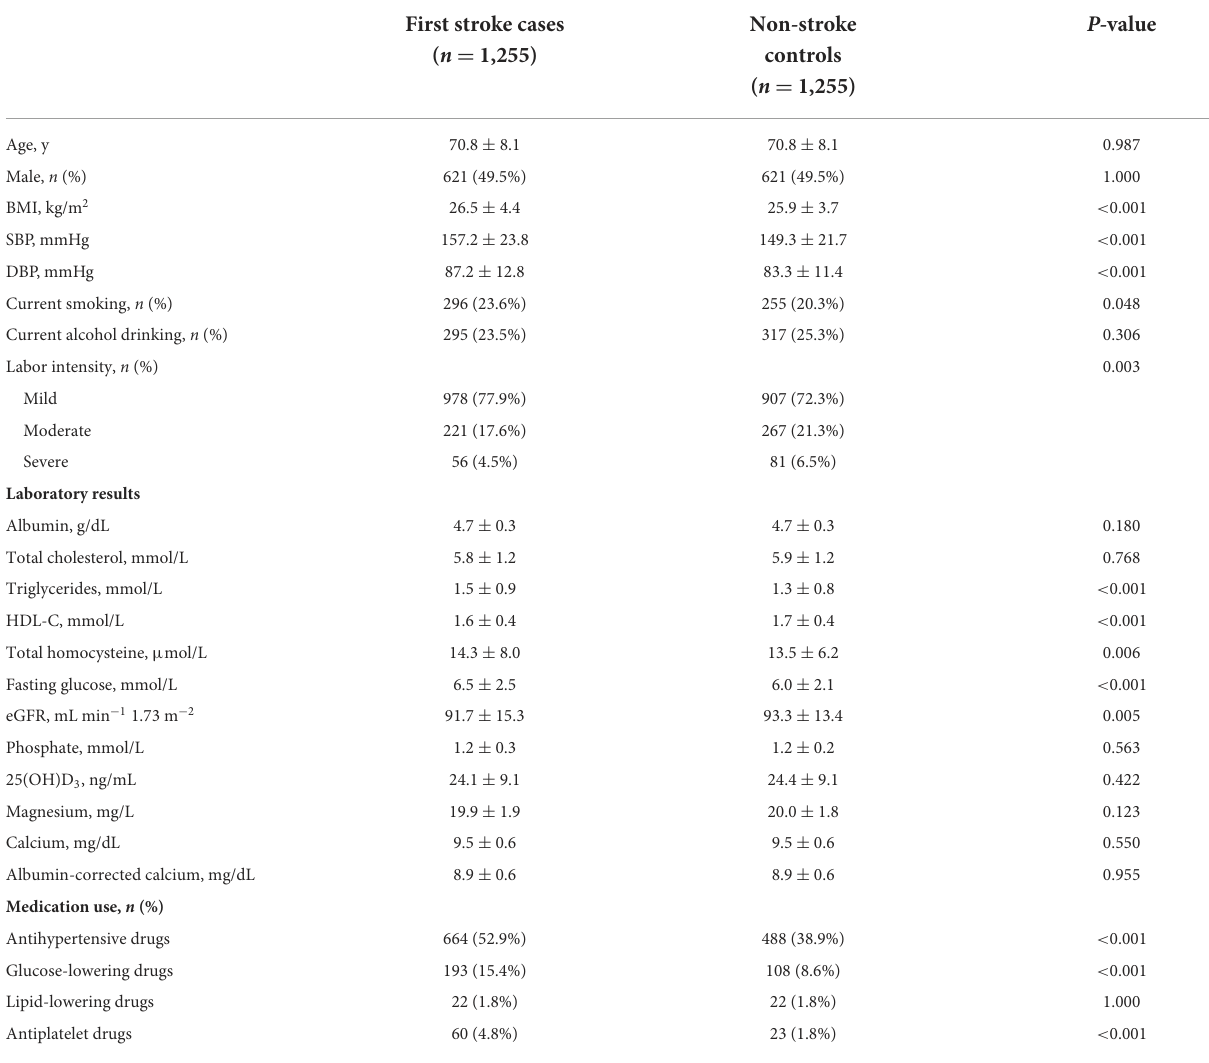
TABLE 1 Baseline characteristics of cases and control subjects *